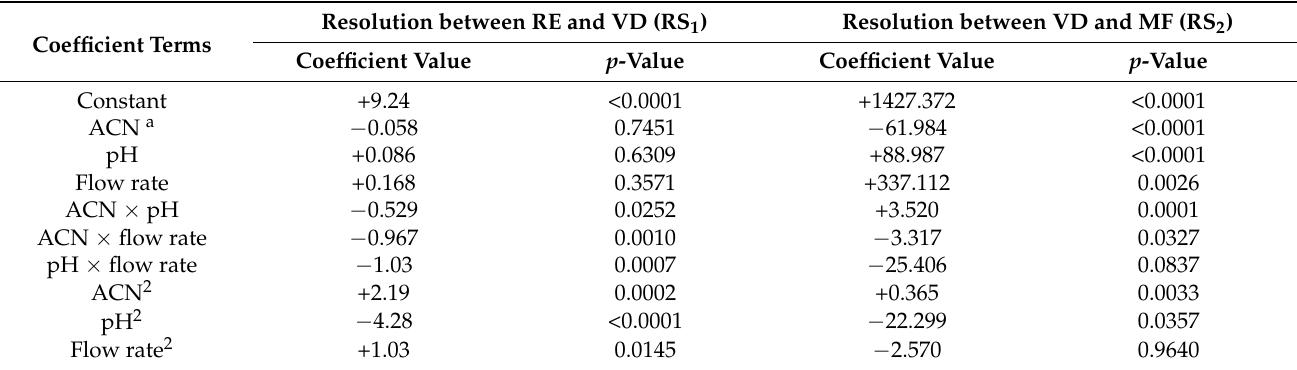
Table 2. Polynomial equation coefficients with corresponding p- values for peak resolution.